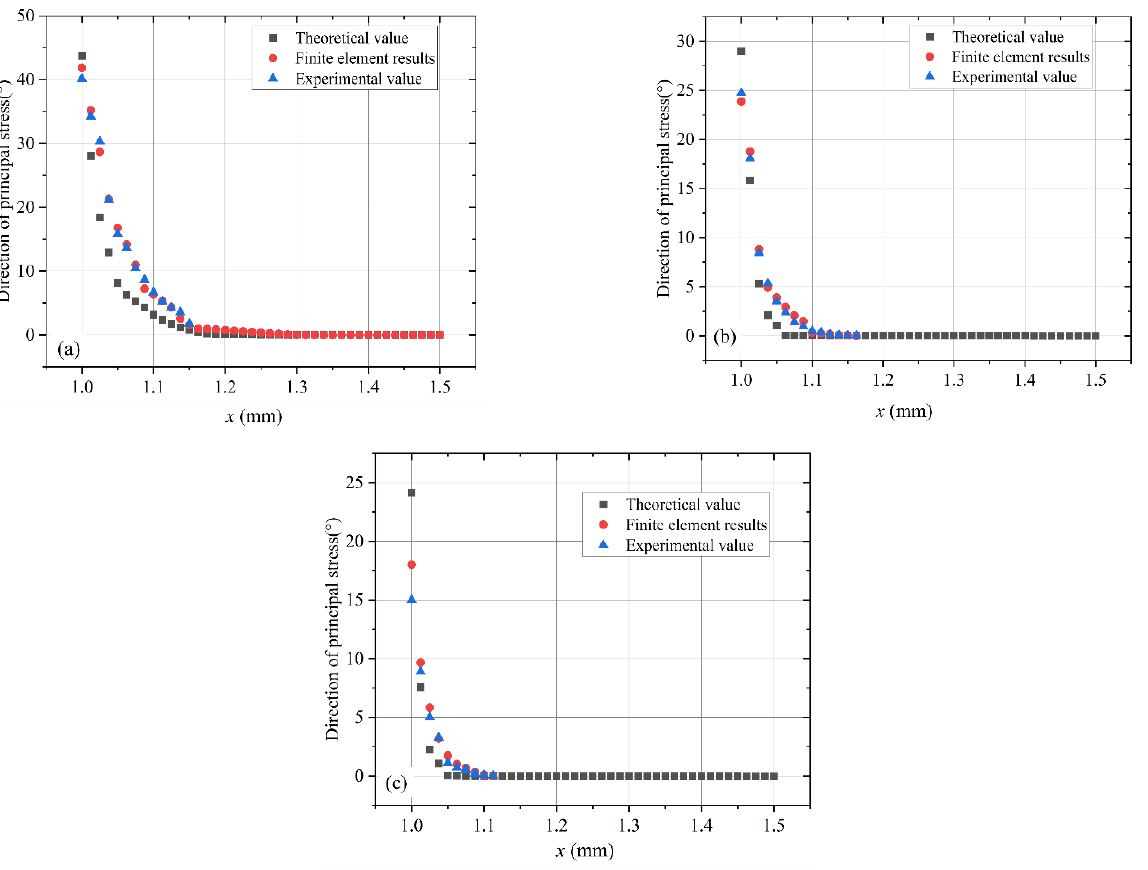
Figure 10. First principal stress distribution of a-a section and the crack propagation direction in the experiment: ( a ) y : x = 1:1, ( b ) y : x = 1.5:1, and ( c ) y : x =